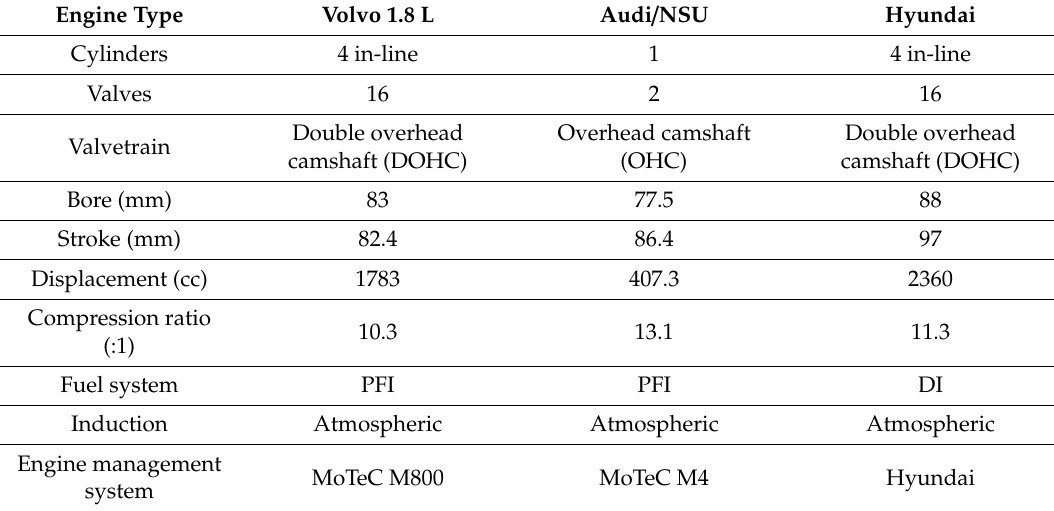
Table 4. Test engine